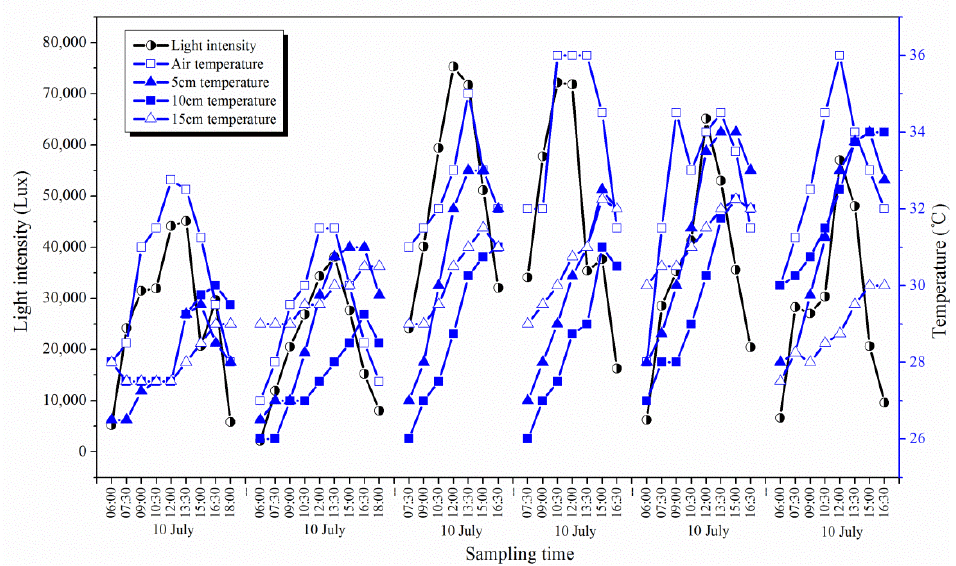
Figure 2. Variations of environmental factors during the research period. Table 1. Correlation relationship between the CH 4 fluxes and environmental